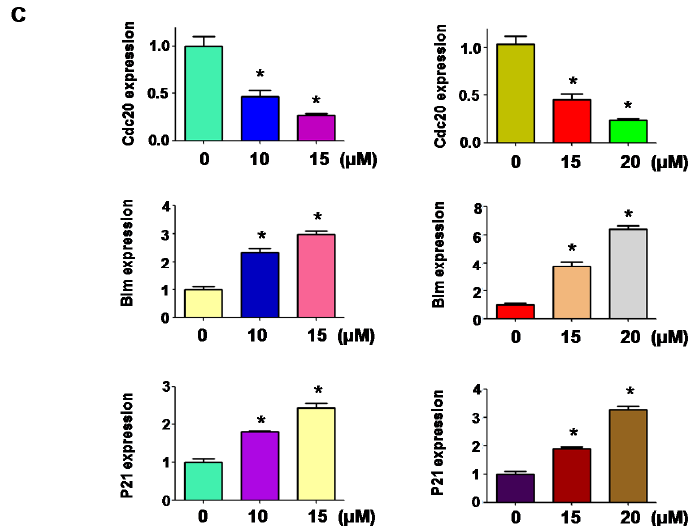
Figure 1. Curcumin decreased cell division cycle 20 (Cdc20) expression at RNA and protein levels. ( A ) The Cdc20 mRNA expression was measured by real ‐ time reverse transcription ‐ PCR (RT ‐ PCR) in PC cells treated with curcumin. * p < 0.05, vs. control; ( B ) The expression of Cdc20, Bim, and p21 was detected using Western blotting analysis in pancreatic cancer (PC) cells after curcumin treatment; ( C ) Quantitative results are illustrated for panel B. * p < 0.05, compared to the control.